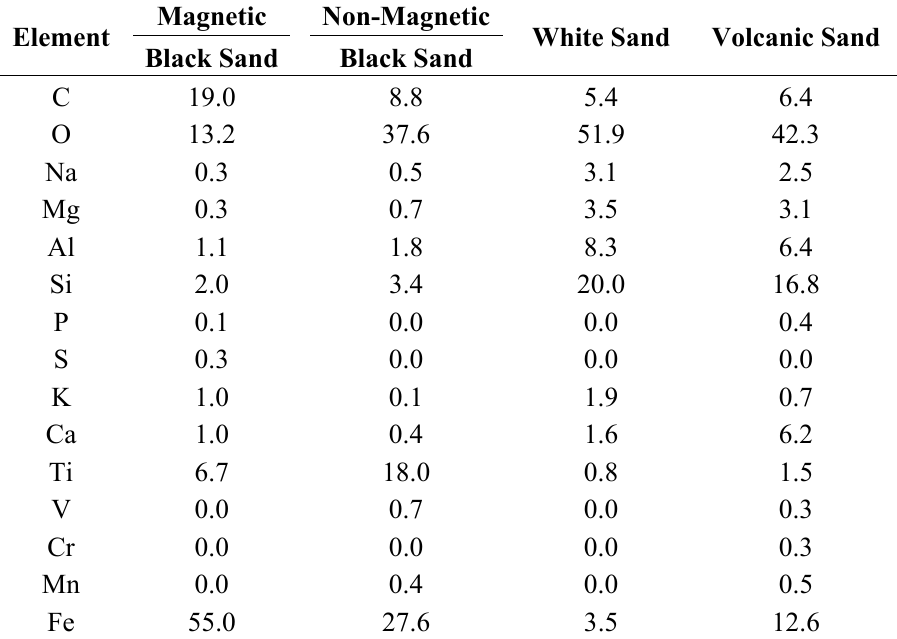
Table 1. Elemental Comparison of Four Sand Grains (Weight %). Magnetic Non-Magnetic Element